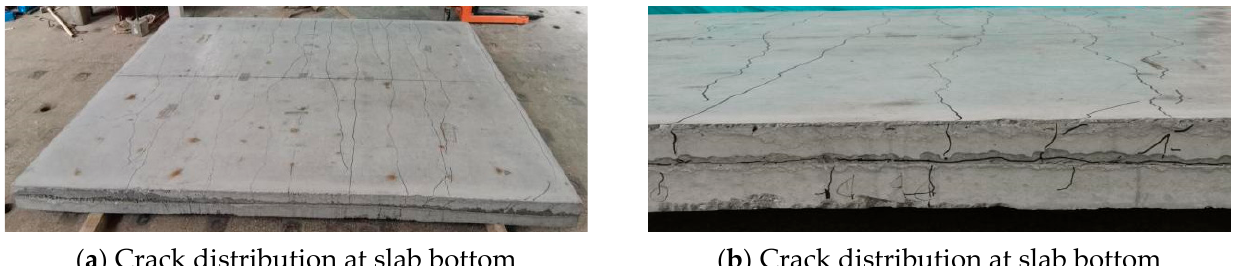
Figure 12. Failure mode and crack distribution of DBD02.